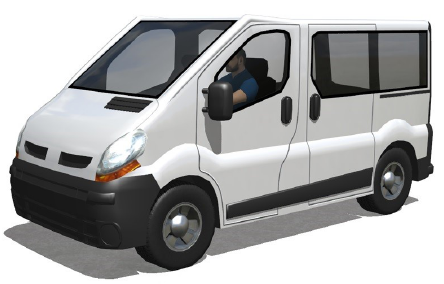
Figure 7. Supplier VAN electrified vehicle used in CarSim ® .